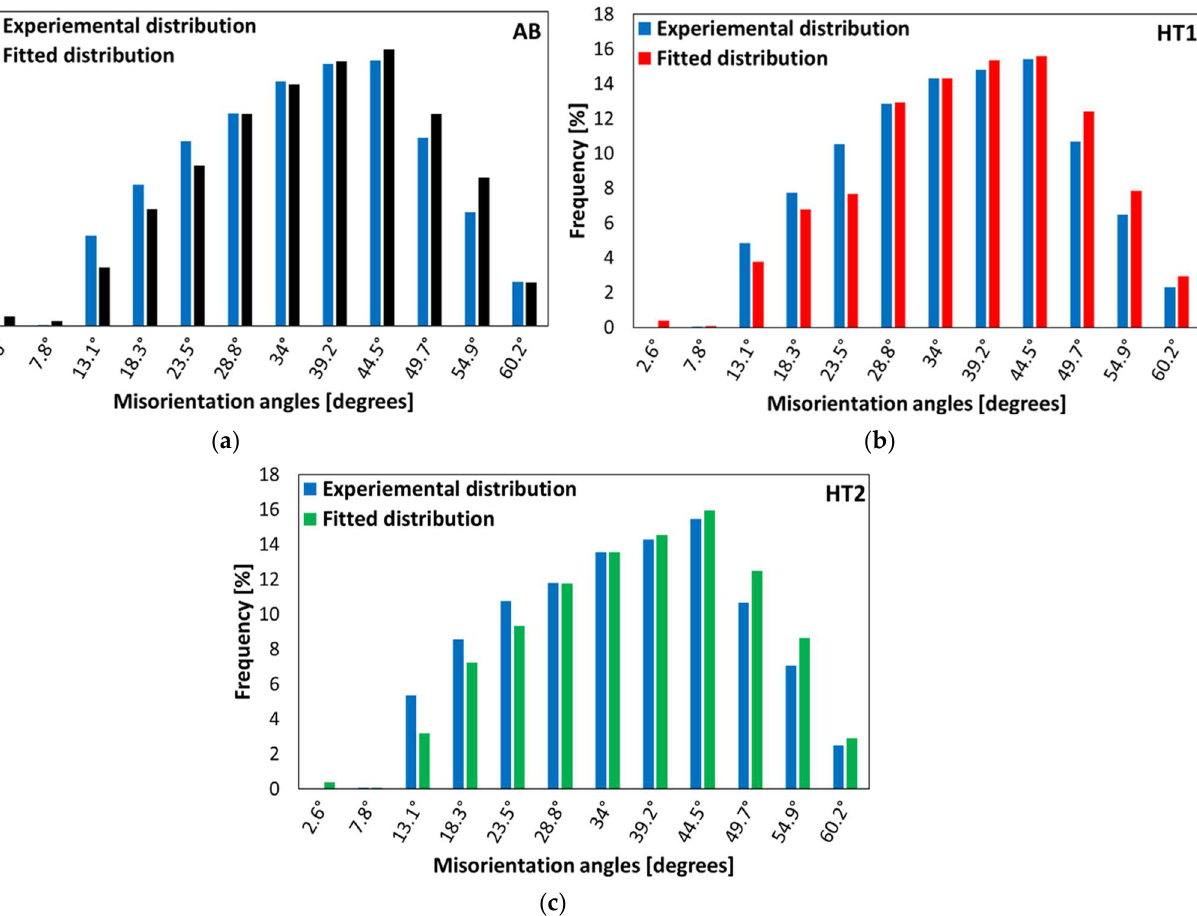
Figure 7. Grain boundary misorientation angle distribution obtained from the experiment and from the Kanapy fitted results, ( a ) AB, ( b ) HT1, and ( c ) HT2 states.